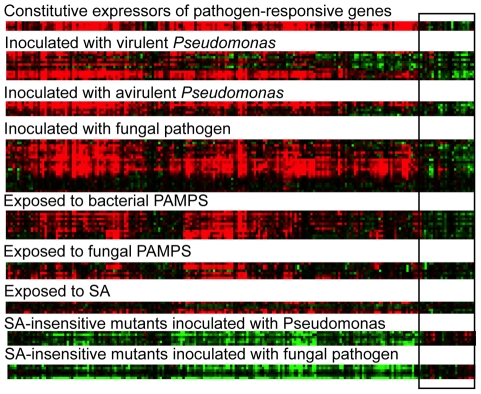
The expression of the 206 ‘common NMD genes’ in response to biotic stimuli.Green indicates that genes are down-regulated, red indicates up-regulation and black indicates that there was no change. The box surrounds genes that were not pathogen-responsive.